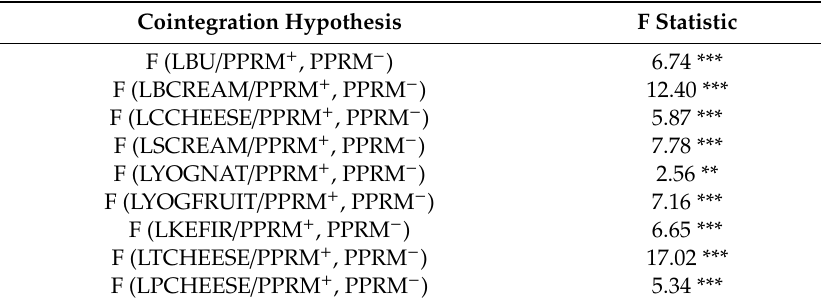
Table 3. Results for the NARDL